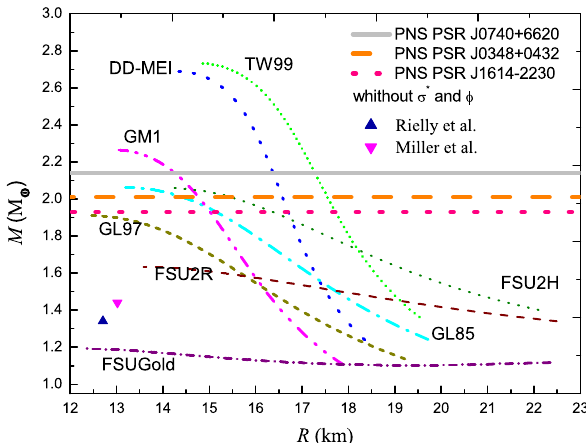
Fig. 1 The mass M of the PNS as a function of radius R . The temper- ature of the PNS is chosen as T = 20 MeV and the interaction between hyperon is not considered